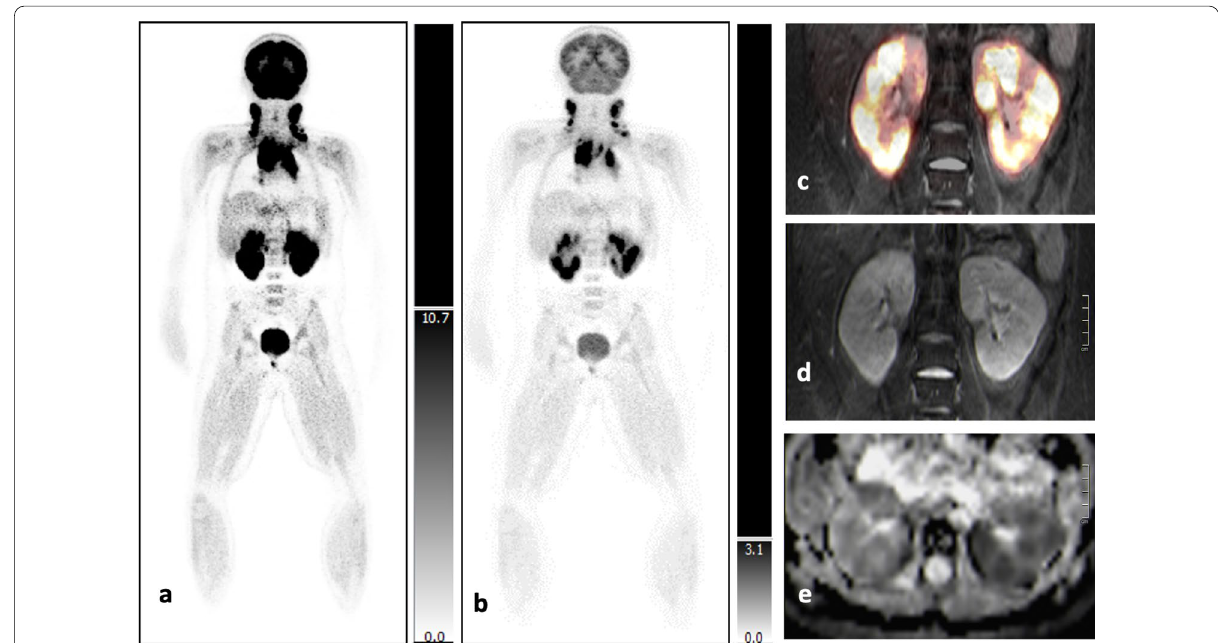
Fig. 6 a–e Coronal [ 18 F]‑FDG‑PET slices with different intensity levels ( a, b ) show the relation between radiotracer accumulation in the bladder (SUVmax 12,8) and both involved kidneys (SUVmax right: 38,02; SUVmax left: 42,91). Coronal fusion images display multiple, metabolically active lesions in both kidneys ( c ). On coronal MR T2‑TIRM images both kidneys are enlarged and corticomedullary junctions are blurred ( d ). Multiple foci in both kidneys are almost restricted in diffusion (ADC about 908 10–6 mm2/s) ( e ×